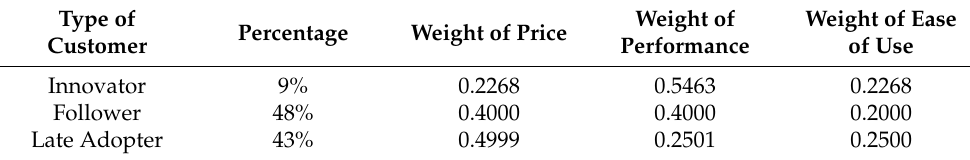
Table 13. Weight of electric vehicle attributes for private car